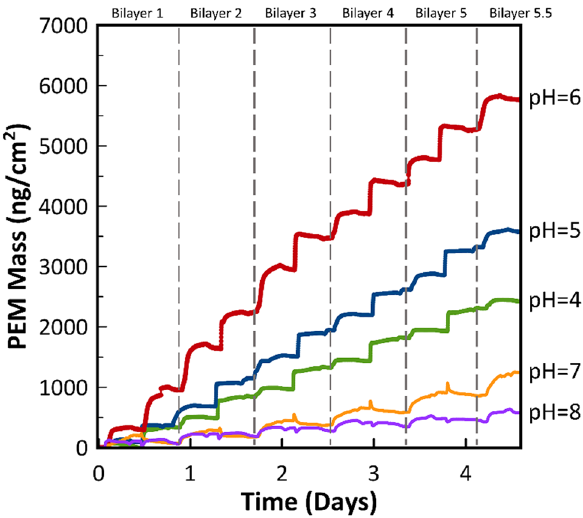
Figure 3. PEM mass during assembly obtained from QCM-D results for (PLH/PMAA) 5.5 PEMs assembled at a pH range from pH = 4 to pH = 8. Polyelectrolyte and wash solutions were fed into the QCM-D at 50 μL/min for 15 min and 10 min, respectively. The final wash continued for an additional 10 min to observe any changes to the